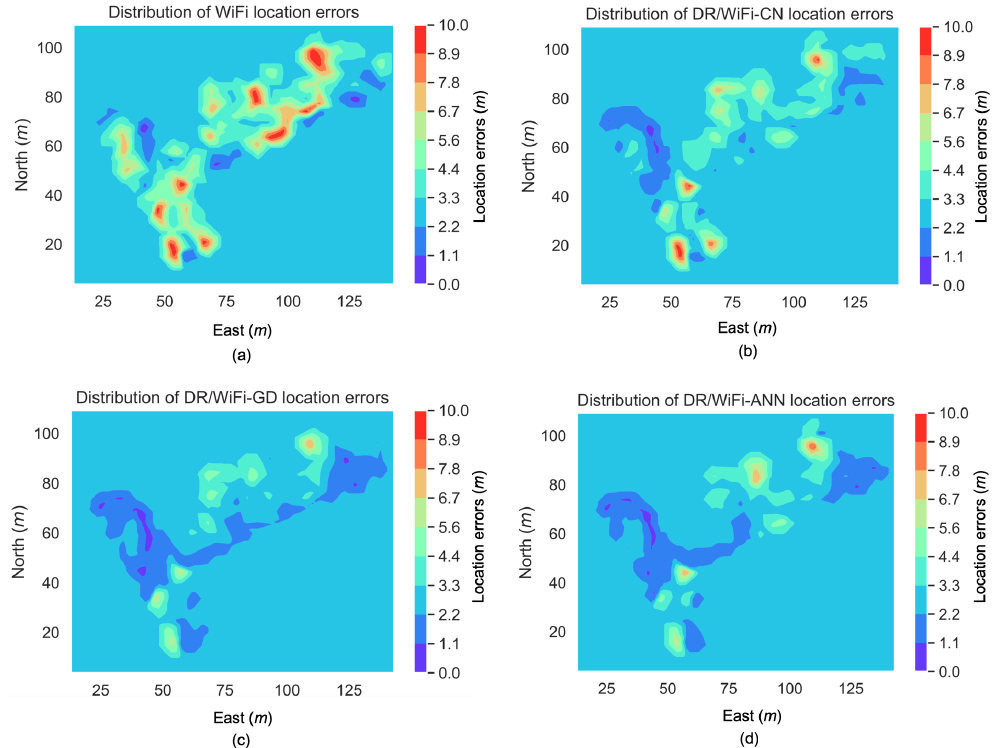
Figure 13. Distribution of location errors from WiFi ( a ), DR/WiFi-CN ( b ), DR/WiFi-GD ( c ), and DR/WiFi-ANN ( d